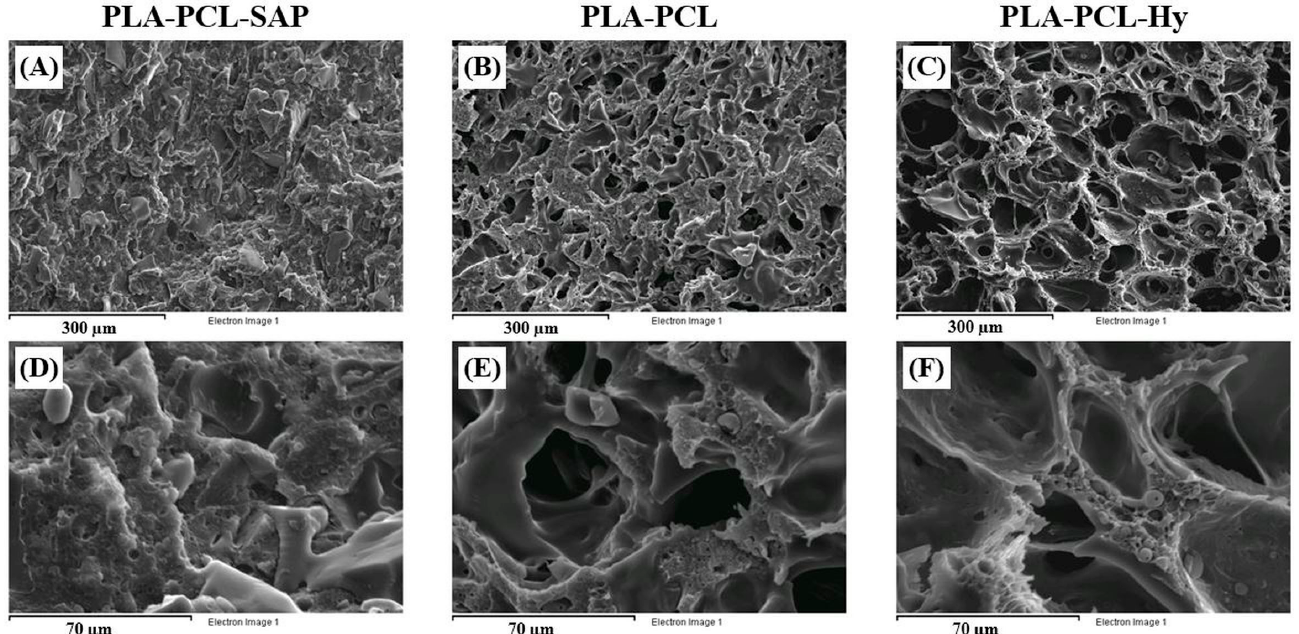
Figure 3. Morphological analysis of cryogenically obtained cross-sections for the PLA-PCL-SAP biocomposite material ( A , D ), for porous PLA-PCL ( B , E ) and for the core-shell assembly, PLA-PCL-Hy ( C , F ). Scale bars 300 µM ( A – C ) and 70 µM ( D – F ).